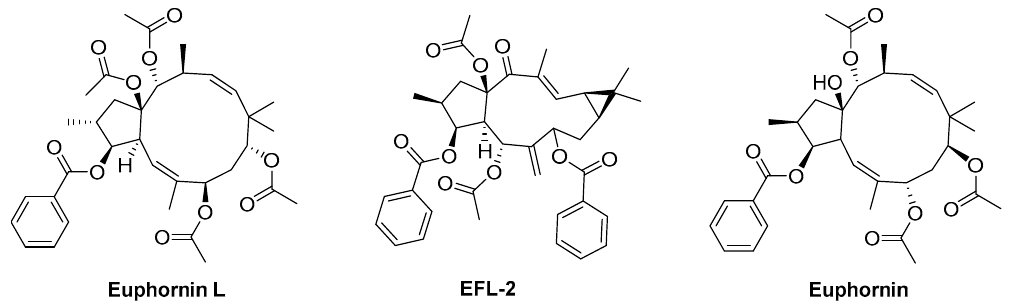
Figure 3. Chemical structures of some in vivo bioactive Euphorbia compounds.